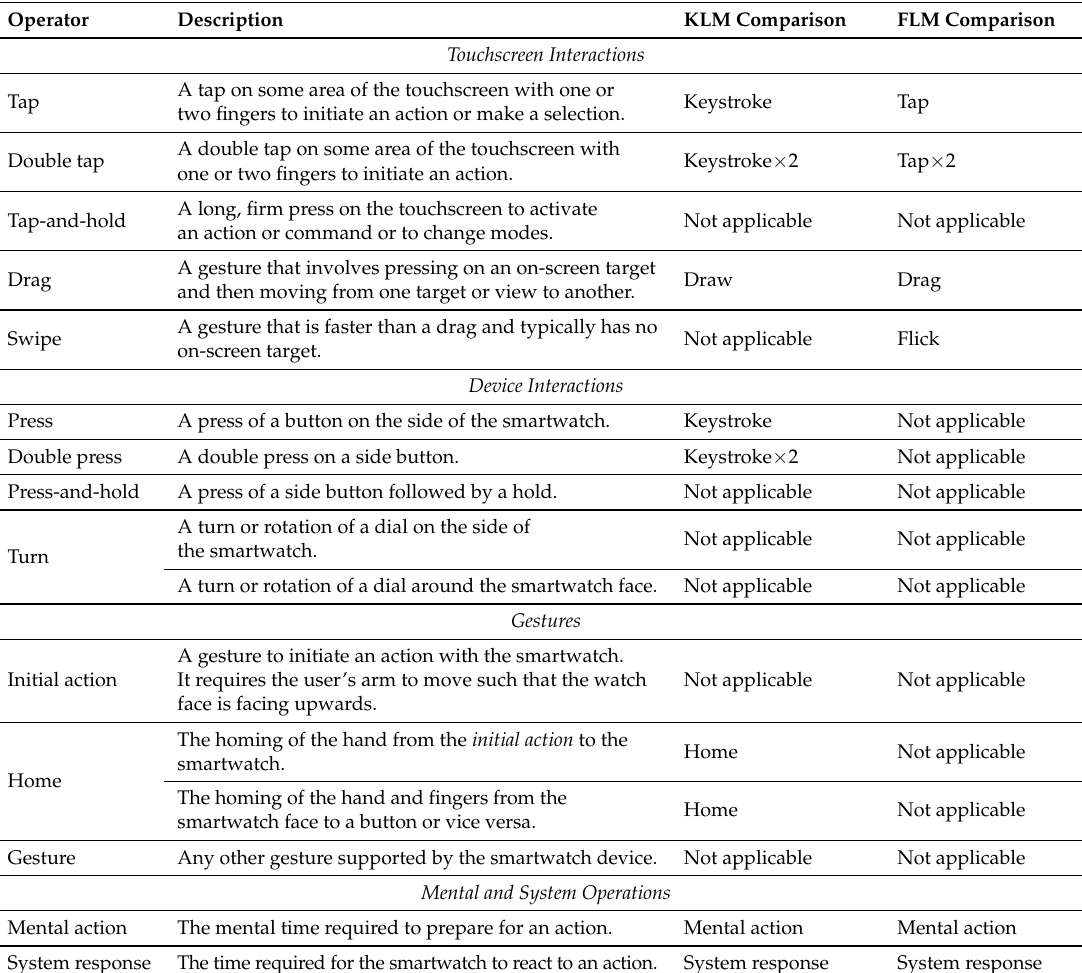
Figure 1. Some of the physical operations performed on the Apple Watch and Samsung Gear. ( a ) Touchscreen interactions [left to right, top to bottom]: tap , drag , swipe , and tap-and-hold ; ( b ) Button and bezel interactions [top to bottom]: turn button , press button , and turn bezel. Table 4. Observed operators for the smartwatch-extended KLM in relation to the original KLM [27] and the FLM